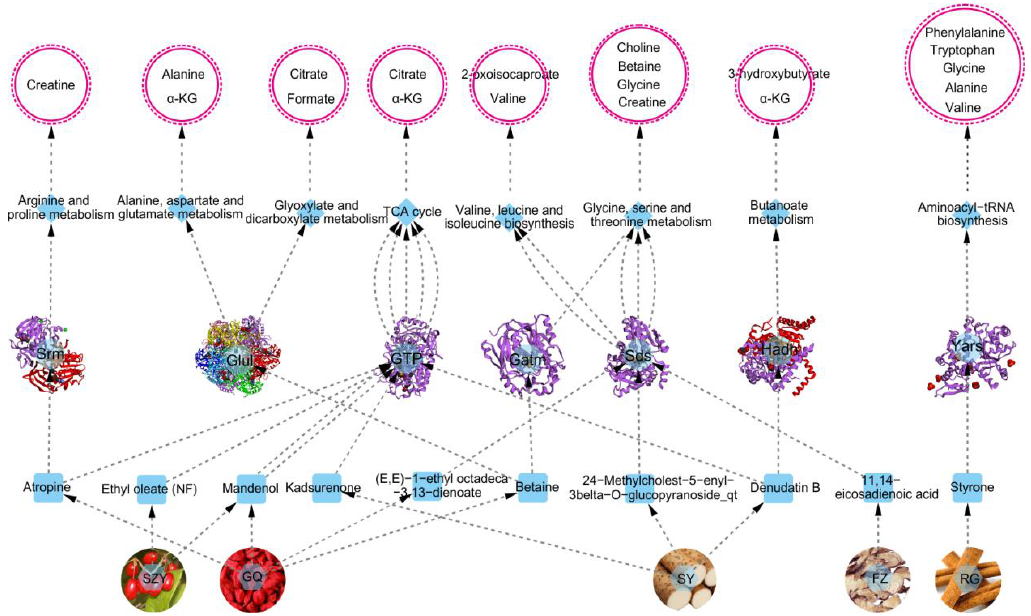
Figure 9. The overall interactive network diagram (herbs, active compounds, target proteins, pathways, and metabolites). SZY: Fructus Corni ; GQ: Fructus Lycii ; SY: Rhizoma Dioscoreae ; FZ: Radix Aconiti Lateralis Prreparata ; RG: Cinnamomi cortex . GTP: phosphoenolpyruvate carboxykinase; Yars: tyrosyl-tRNA synthetase; Srm: spermidine synthase; Sds: L-serine dehydratase; Hadh: 3-hydroxyacyl-CoA dehydrogenase; Glul: glutamine synthetase; Gatm: glycine amidinotransferase.